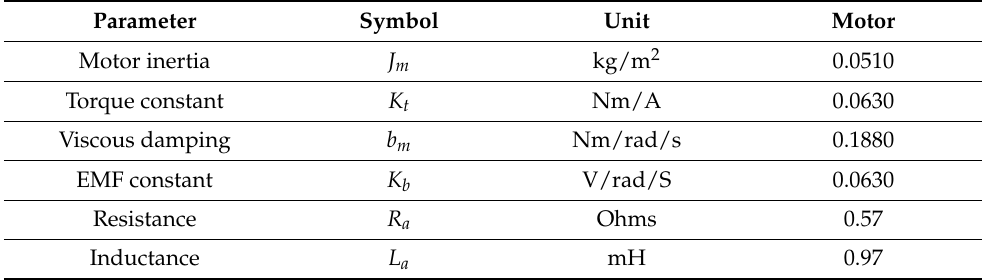
Table 1. 12 V DC MOTOR